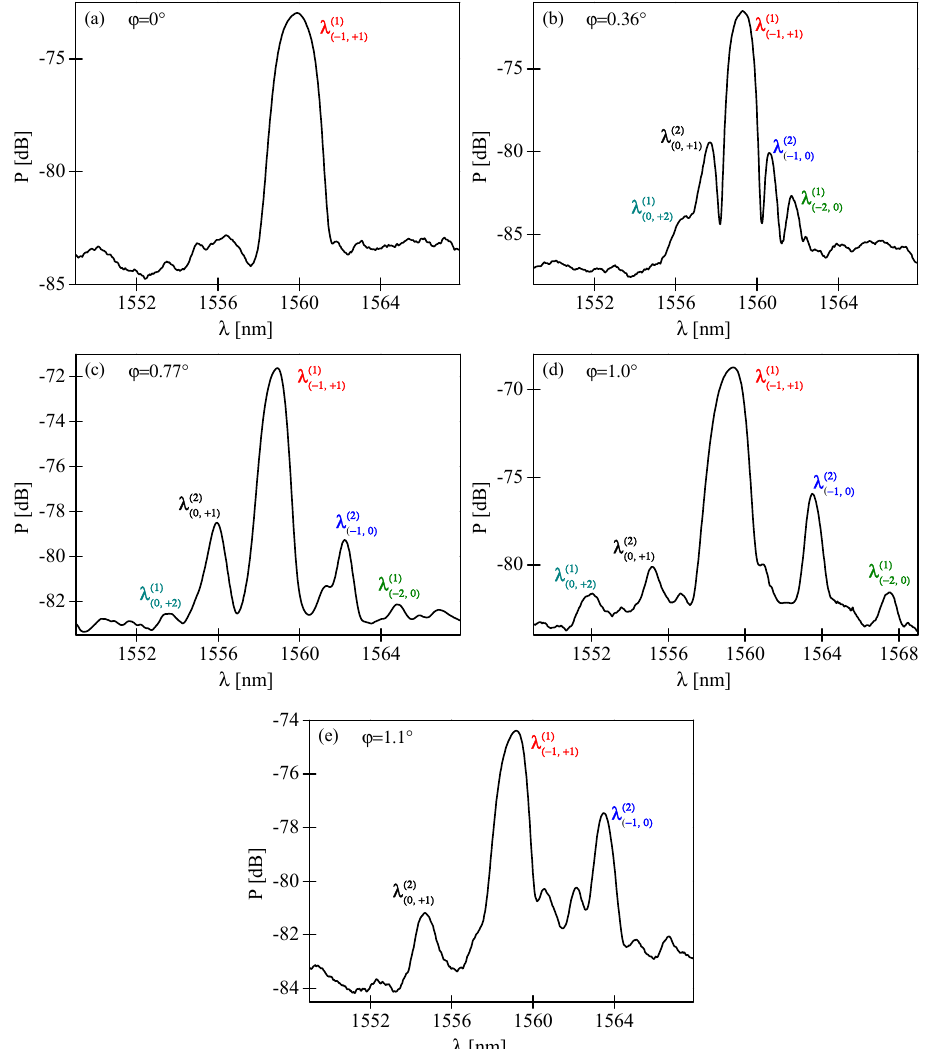
Figure 8. The reflection spectra near the primary Bragg wavelength λ B of the FBGs fabricated in fibers tilted in respect to the phase mask with the angle ϕ = 0° ( a ), ϕ = 0.36° ( b ), ϕ = 0.77° ( c ), ϕ = 1.0° ( d ) and ϕ = 1.1° ( e ).